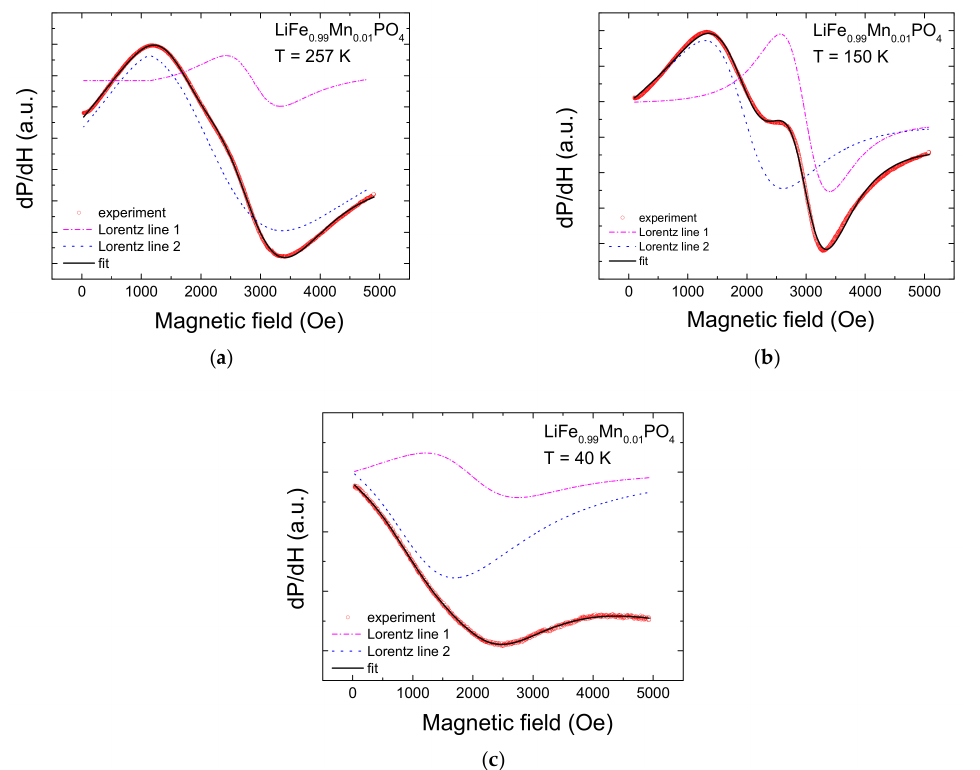
Figure 4. Decomposition of the ESR spectra of LiFe 0.99 Mn 0.01 PO 4 at different temperatures: ( a ) T = 257 K, ( b ) T = 150 K, and ( c ) T = 40 K.